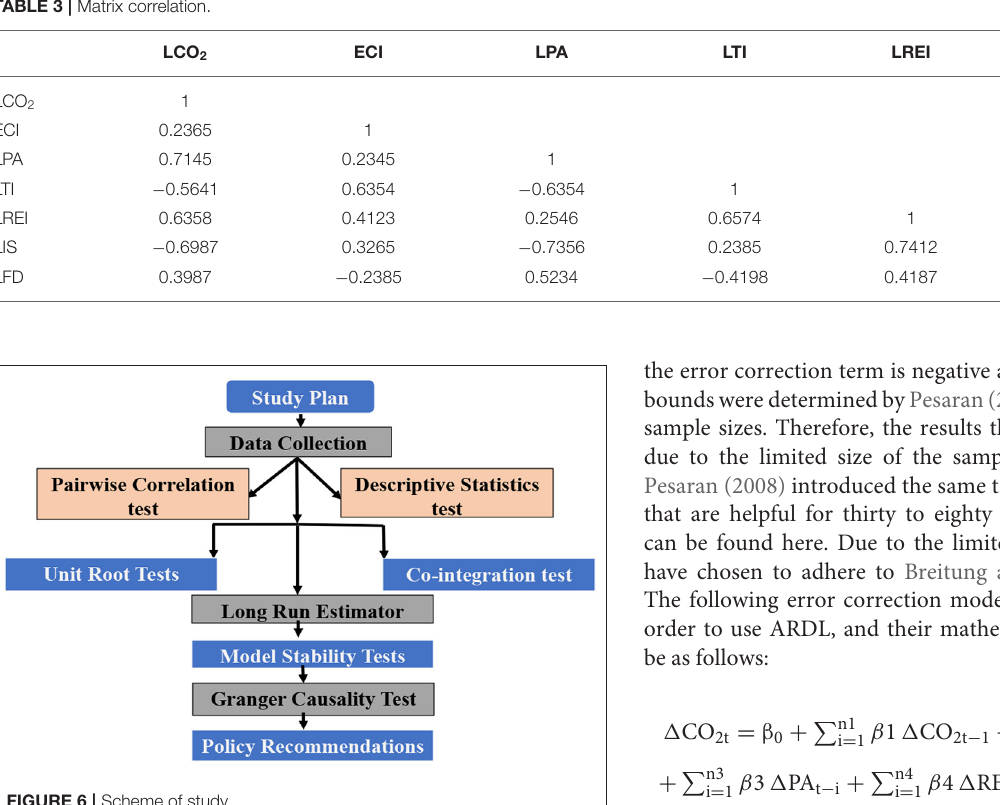
FIGURE 6 | Scheme of